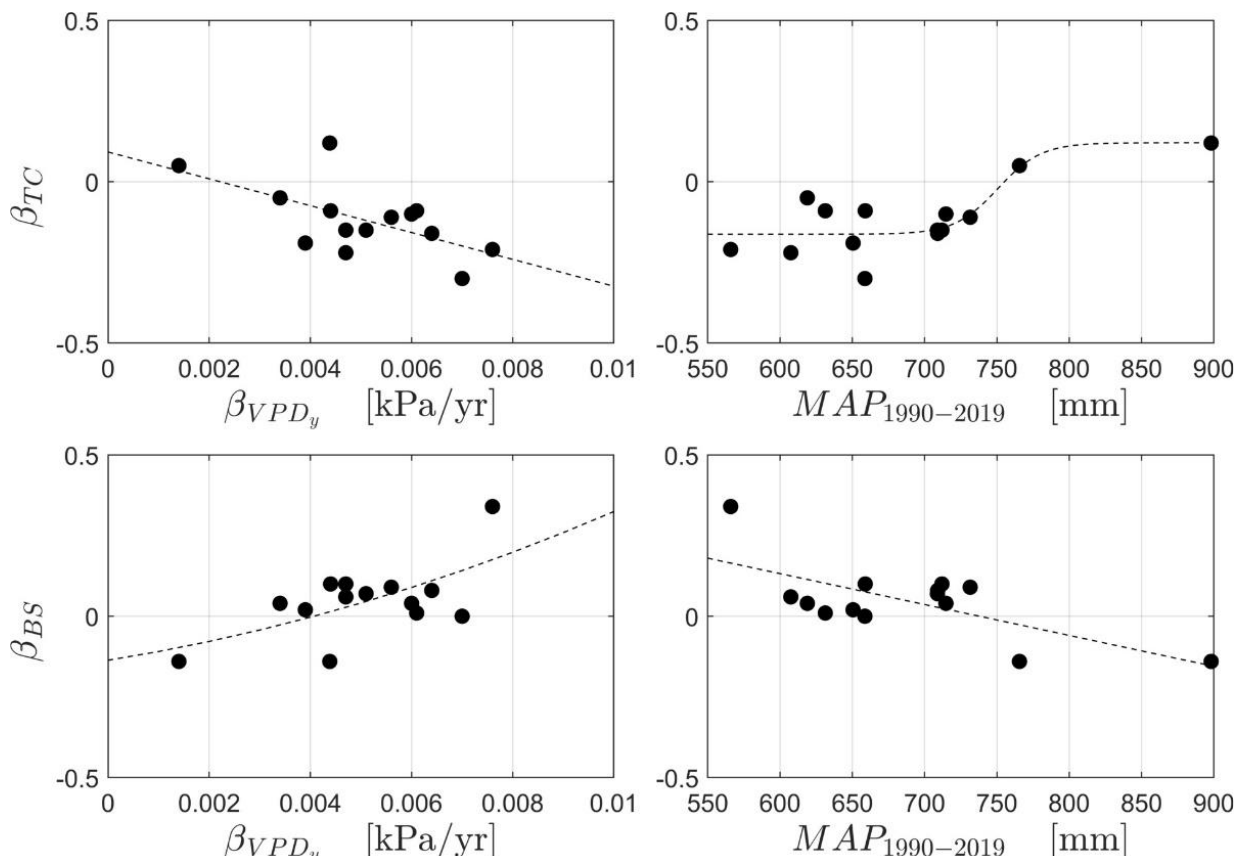
Figure 9. Scatterplot of β Theil-Sen slope estimator values for the tree cover ( β TC ) and for the bare soil ( β BS ) in broad-leaved forests as a function of β Theil-Sen slope estimator for annual VPD ( β VPDy ), and MAP 1990–2019. The equations of the fitted functions (thin dotted lines) are reported in the text with statistics of the goodness of fit.